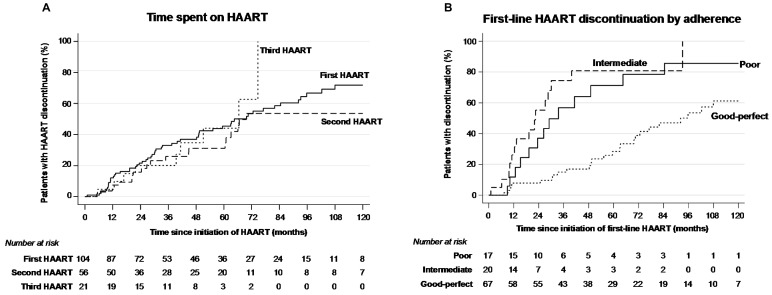
Kaplan–Meier survival curves for time spent on first vs. second vs. third HAART (A) and for time spent on first HAART by adherence to antiretrovirals (B).